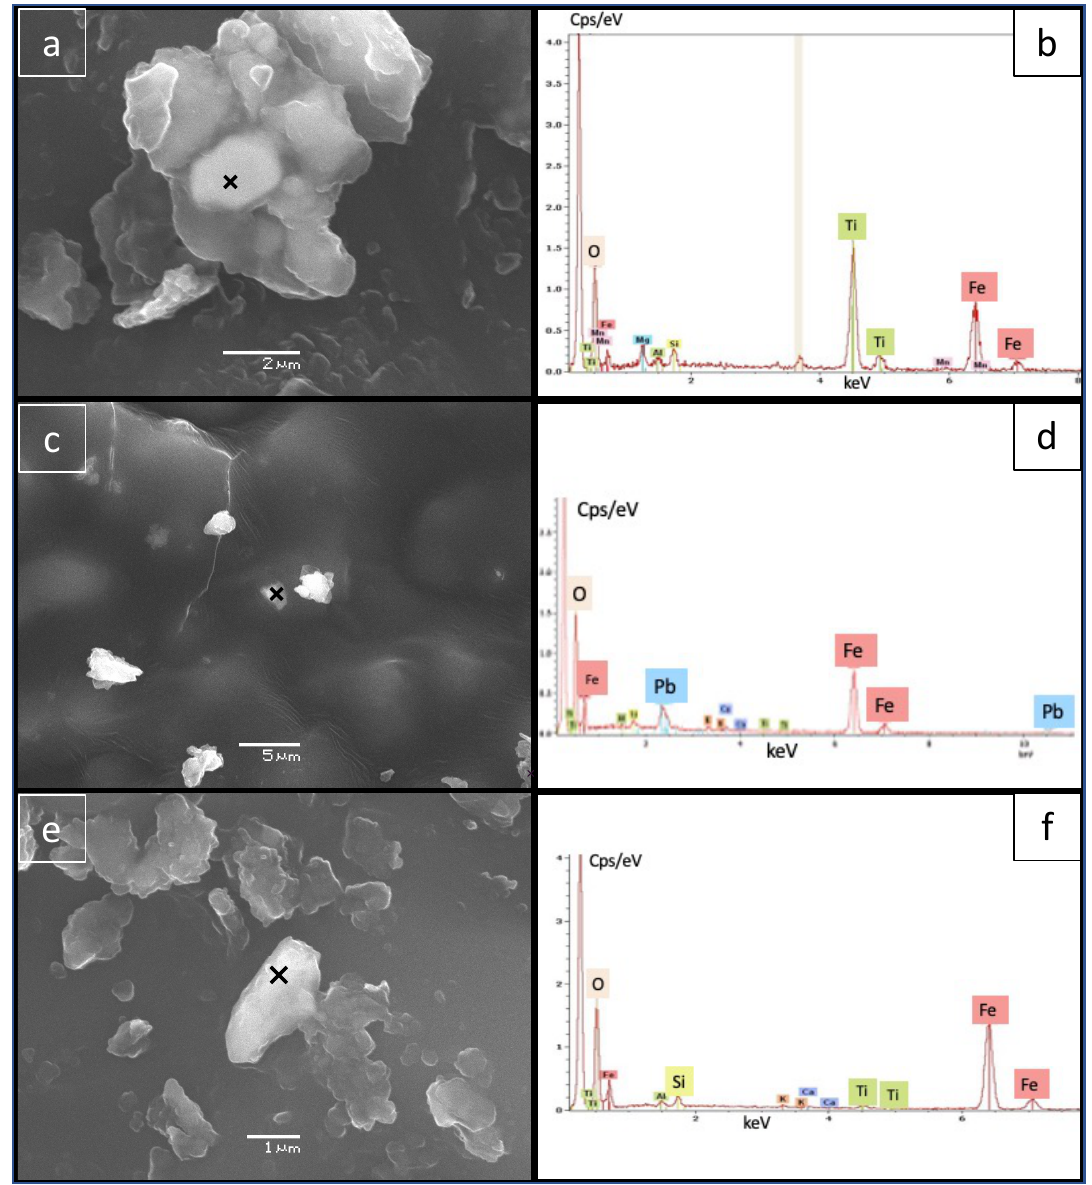
Figure 9. SEM observations on a leaf from site D48 taken during campaign D ( a,c,d ) and respective EDS spectra ( b,d,f ) acquired on the location marked by the